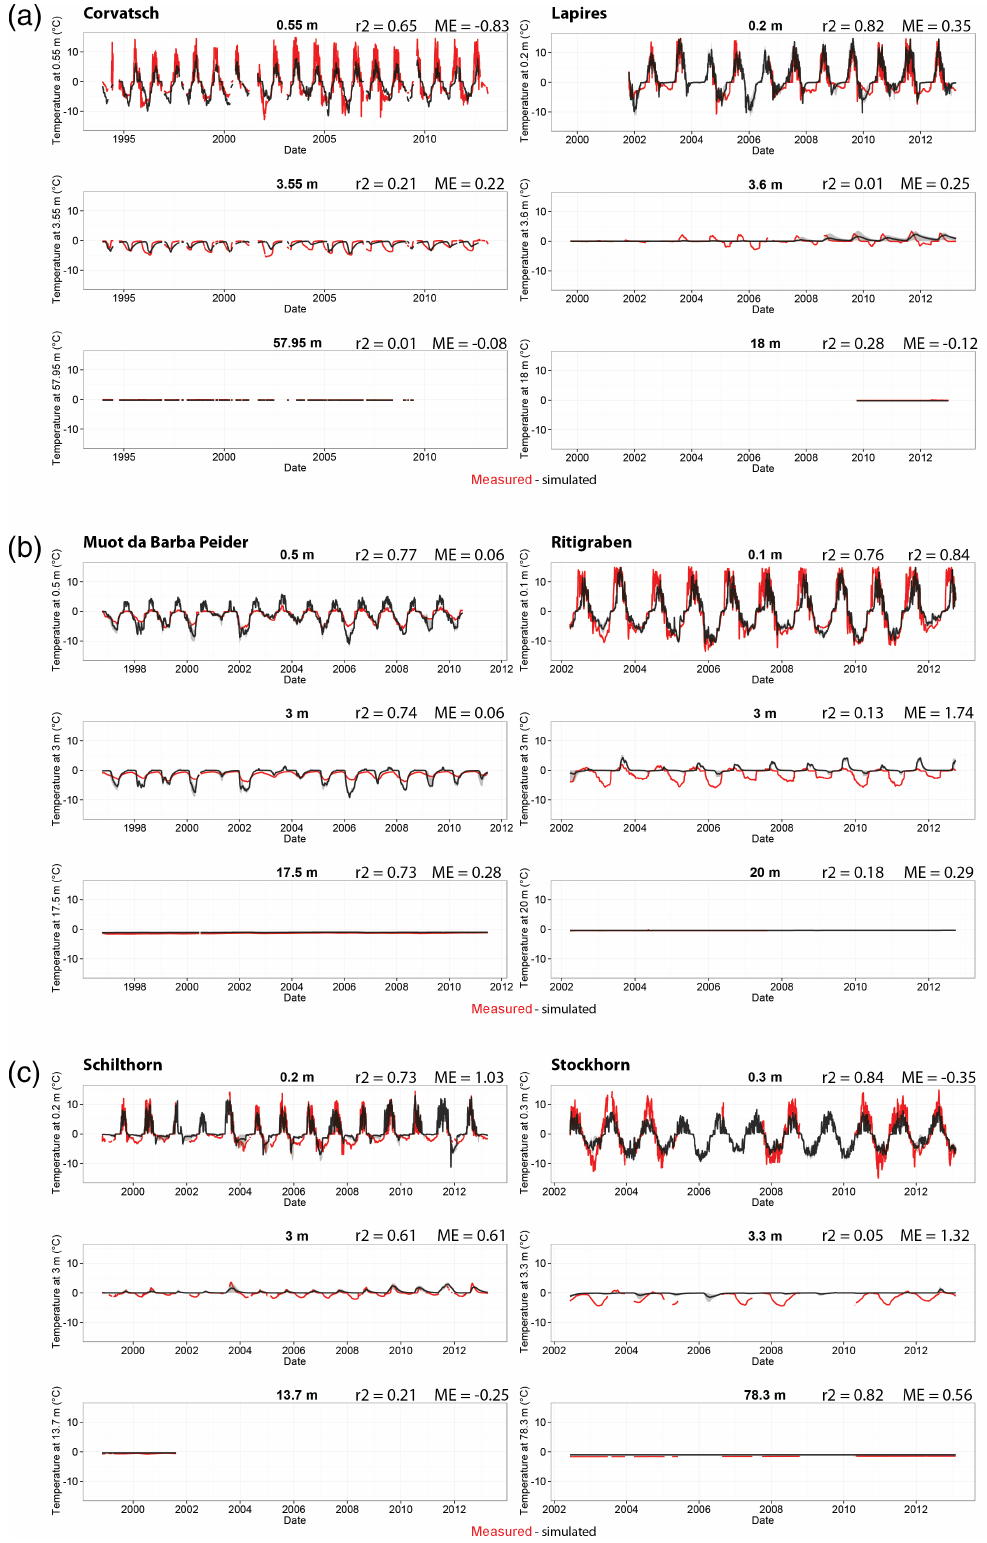
Figure 6. (a) Comparison of simulated (black) and measured (red) temperature during the calibration period at six sites at three different depths: one close to the surface, one around 3m and one close to the lower boundary of the model for Corvatsch and Lapires. (b) As in (a) but for Muot da Barba Peider and Ritigraben. (c) As in (a) but for Schilthorn and Stockhorn. The Cryosphere, 10, 2693–2719, 2016